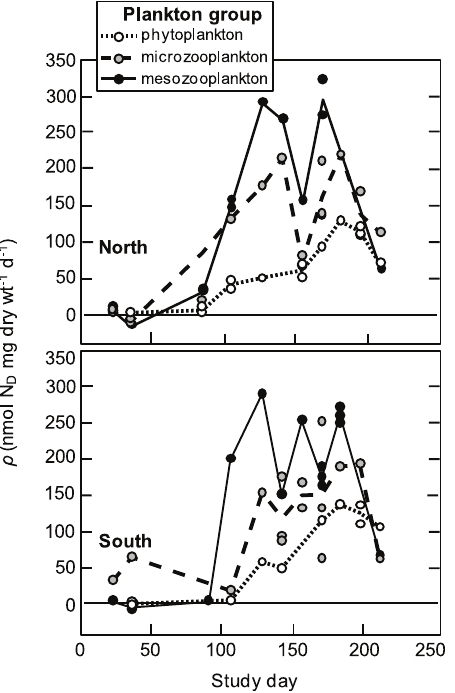
Figure 3. Time series of plankton diazotrophic nitrogen flux rates. Time series of size-fractioned plankton N D flux rates (nmol N D mg dry wt 2 1 day 2 1 ) collected at a north (upper panel; N isotope =52) and south (lower panel; N isotope =48) sampling site in Lake King,